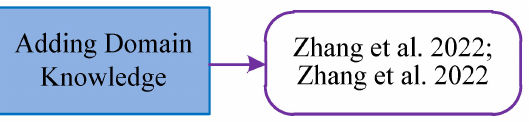
Figure 19. Adding domain knowledge in SAR ATR